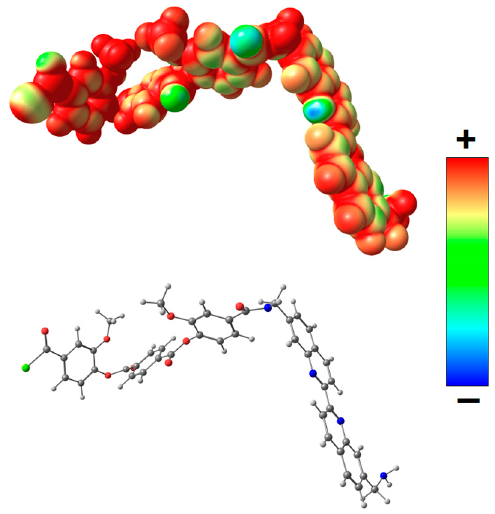
Figure 11. Distribution of electrostatic potential V S ( r ) calculated on the 0.001 a.u. molecular surface for the optimized equilibrium model structure A. From red to blue, the electrostatic potential is becoming increasingly negative.